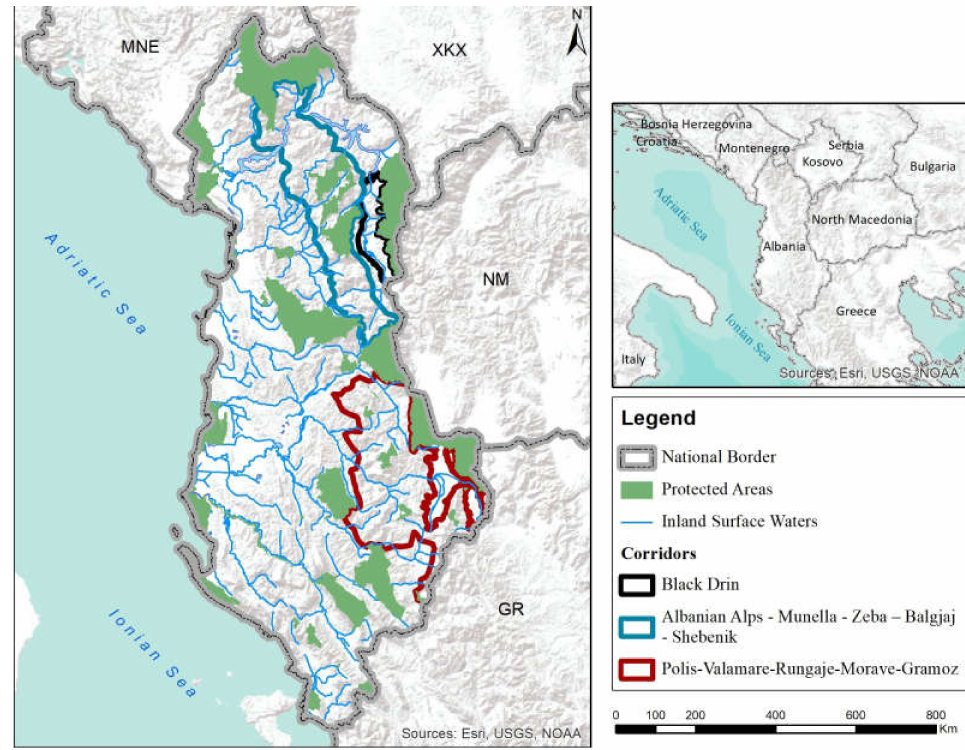
Figure 1. Map of Albania considering the potential landscape corridors (Melovski et al., 2022).